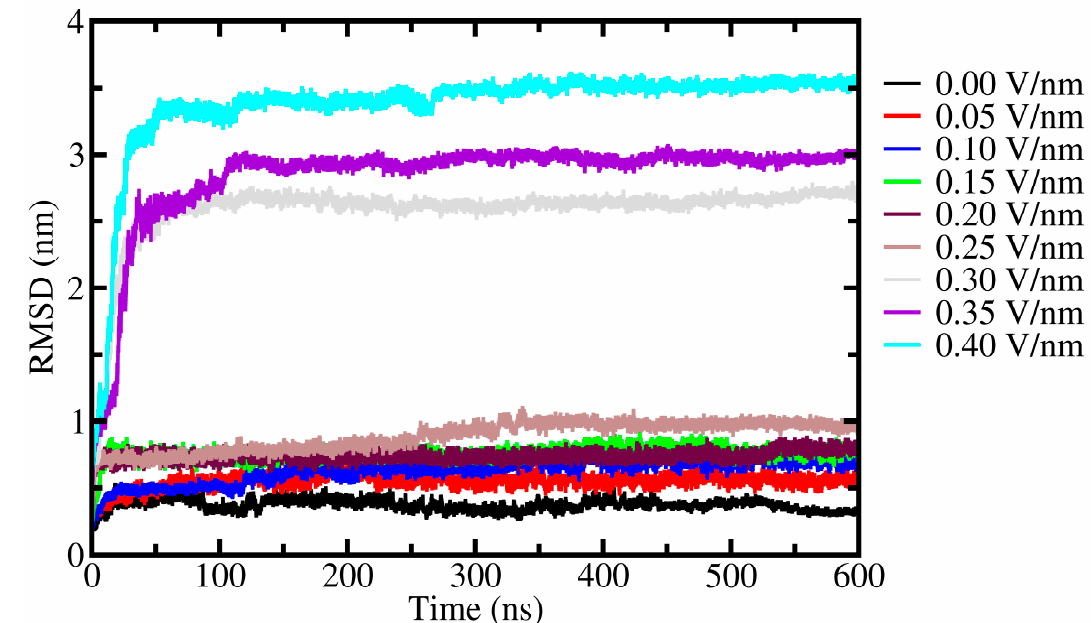
Figure 3. The RMSD of backbone structure of α -synuclein fi bril. Figure 2. The RMSD of backbone structure of α -synuclein fibril.